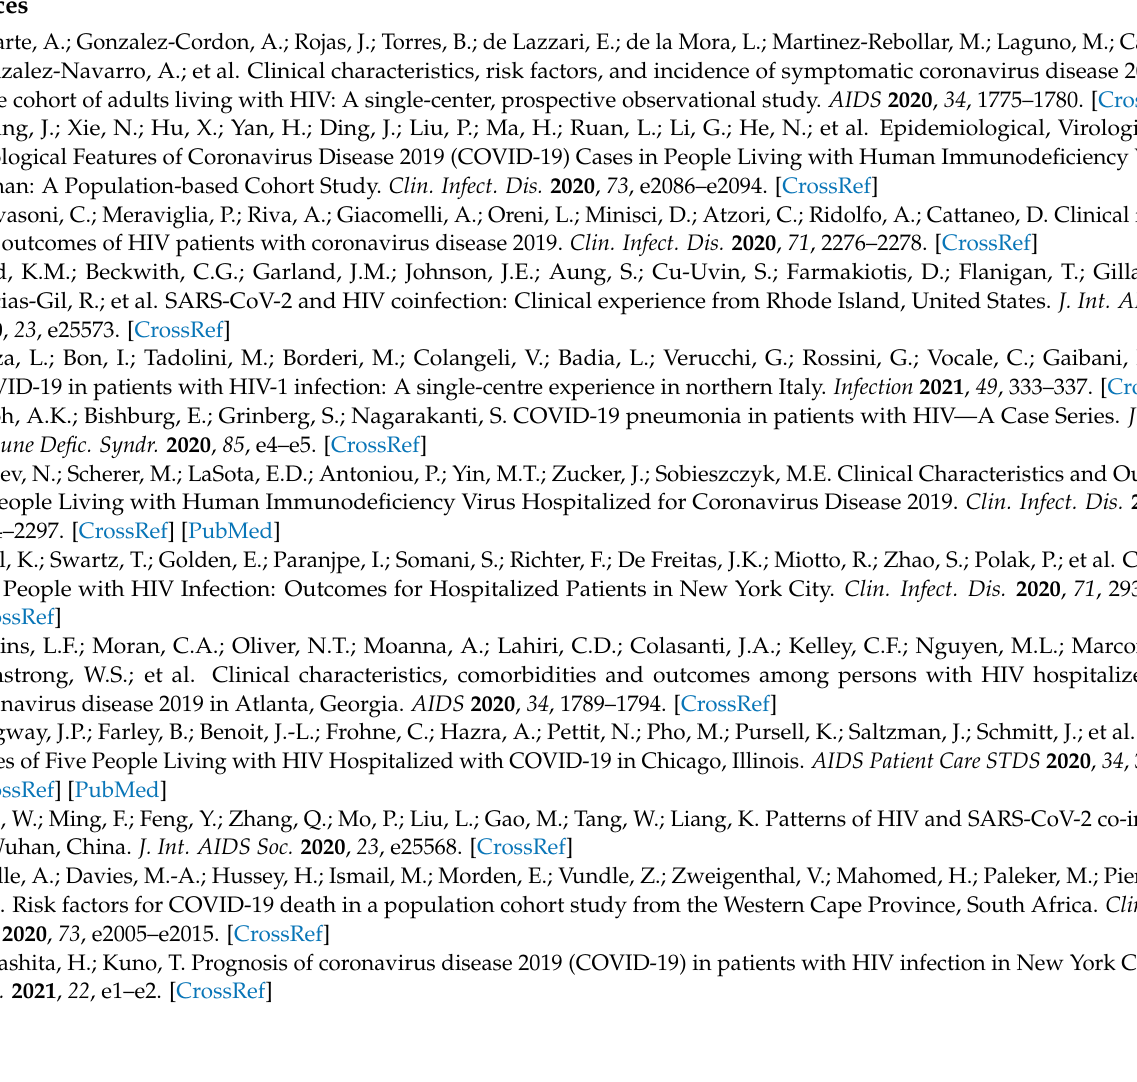
Table S2: Characteristics of persons living with HIV who completed SARS-CoV-2 testing with and without